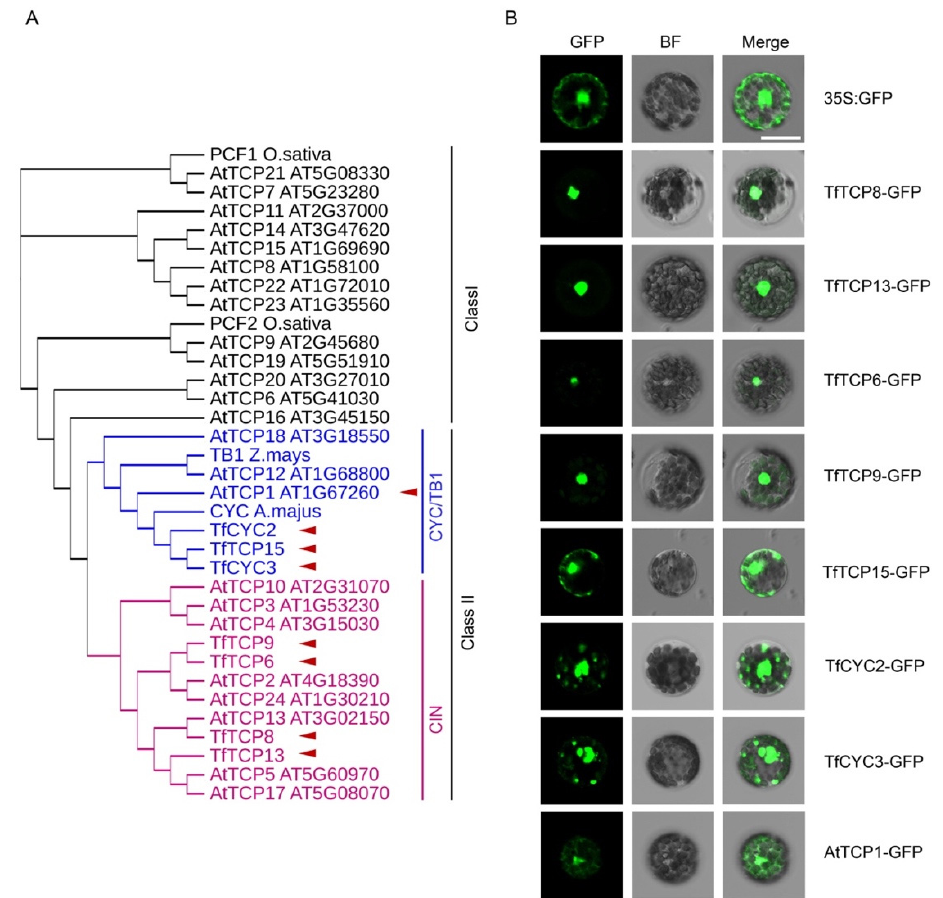
Figure 3. Sub-cellular localization of TCP transcription factors in torenia protoplast. ( A ) Phylogenetic tree of the TCPs. The 7 reported TfTCPs, 24 Arabidopsis TCPs (AtTCPs), as well as A. majus CYC, Z. mays TB1 and O. sativa PCF1/2 were clustered into Class I or Class II, using the neighbor-joining algorithm. Class II can be further divided into two subclasses, CIN and CYC/TB1. ( B ) Sub-cellular localization of selected TCPs (marked in red triangle in left panel). BF: Confocal brightfield channel; Merge: Merge of GFP and BF channel. Scale bar = 20 μ m.